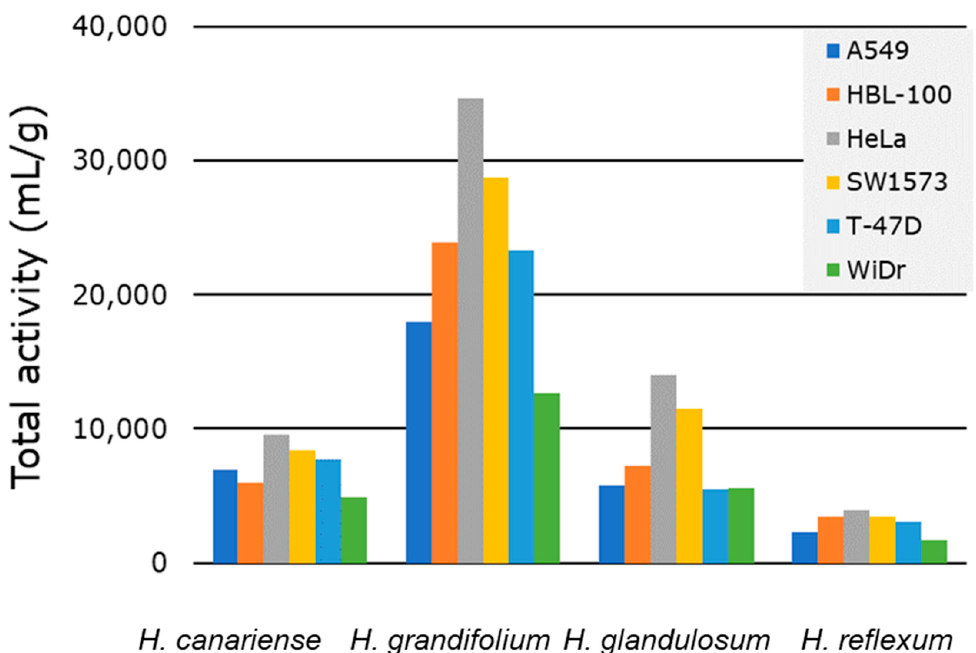
Figure 3. Total activity (GI 50 ) of microextracts from Hypericum species.